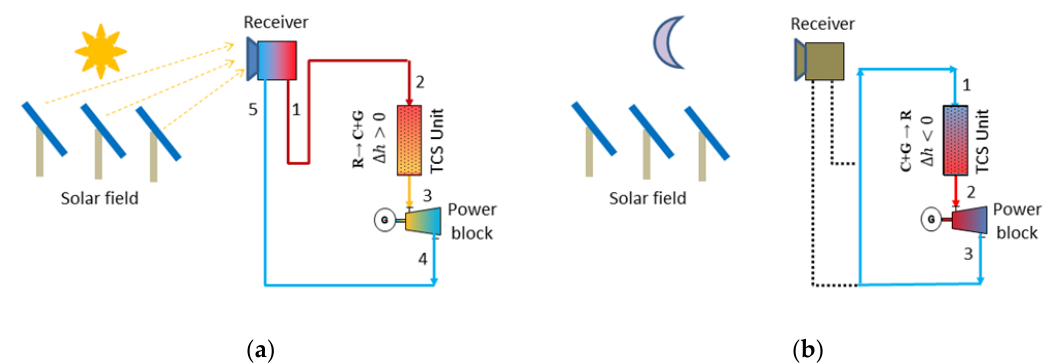
Figure 3. Conceptual scheme for the integration in series between thermochemical storage and power block, ( a ) charging operation (on-sun); ( b ) discharging operation (off-sun).